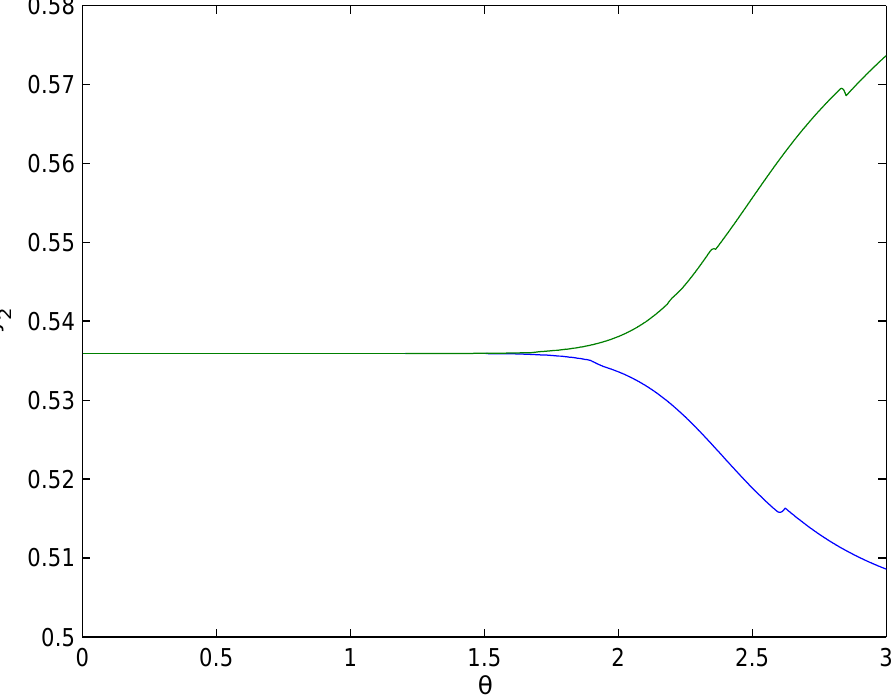
Figure 4. Bifurcation figure of model (62): the relation of t and y 2 . The bifurcation value is approxi- mately equal to